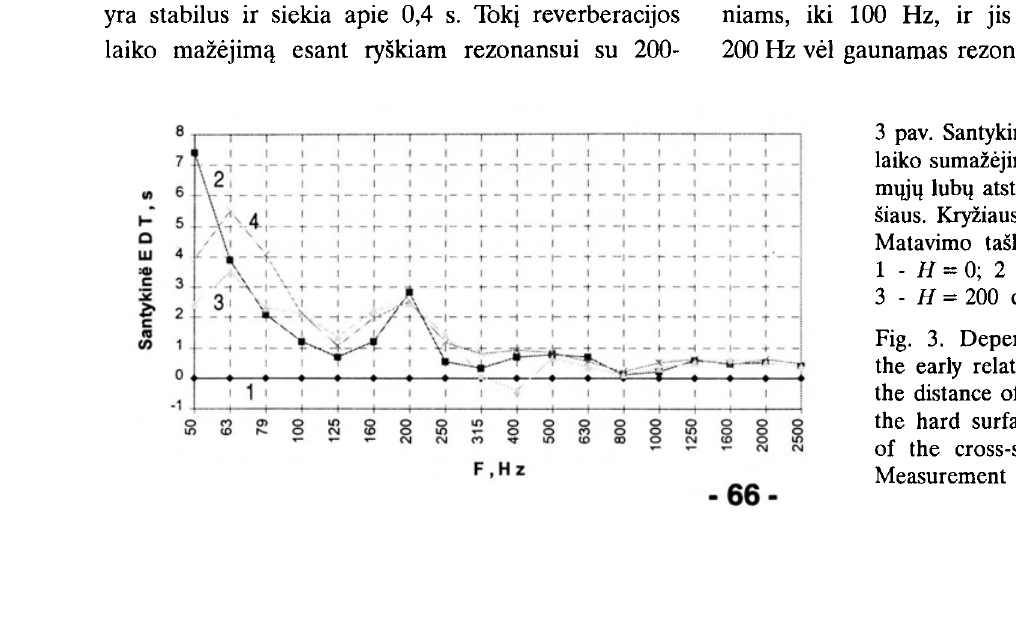
Fig. 3. Dependence of the decrease in the early relative reverberation time upon the distance of the suspended ceiling from the hard surface of the ceiling. The area of the cross-shaped aperture is 50 em. Measurement point